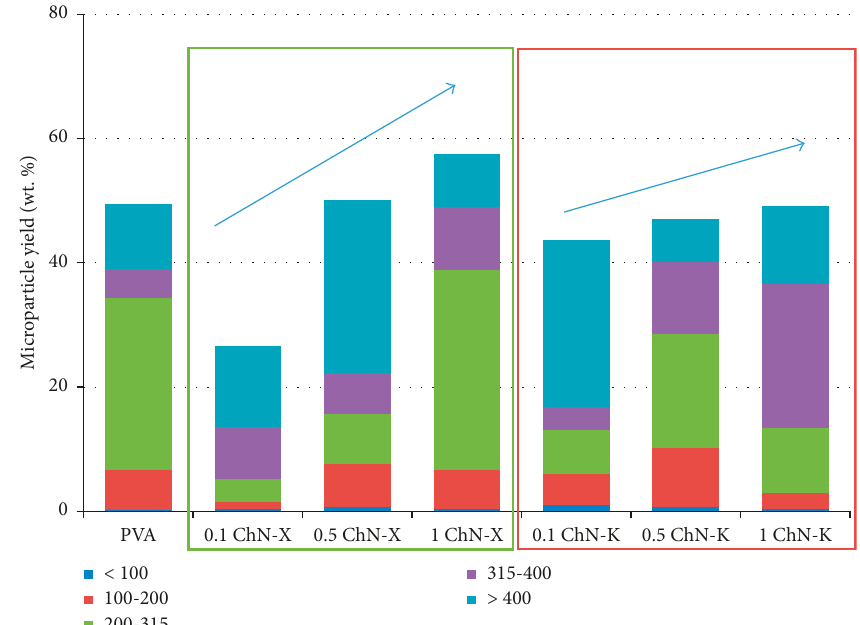
Figure 5: The total yield and microparticle size distribution as a function of origin and concentration of chitin nanocrystals in the aqueous